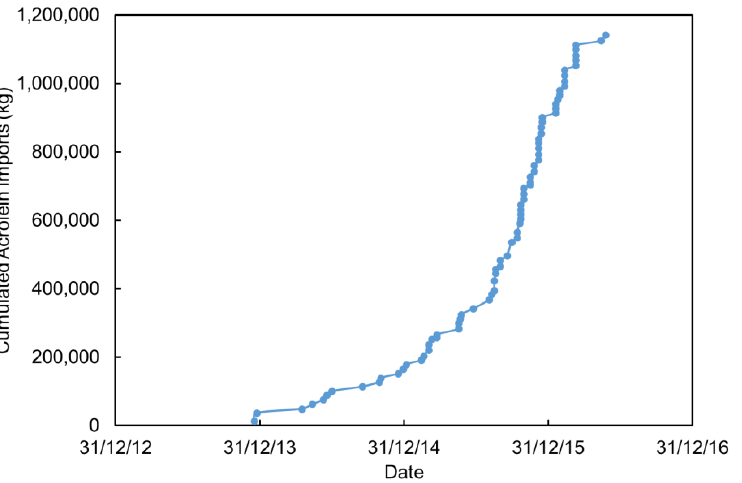
Figure 8. Cumulated quantities of acrolein imported in India between 2013 and 2016. Data computed from [74].